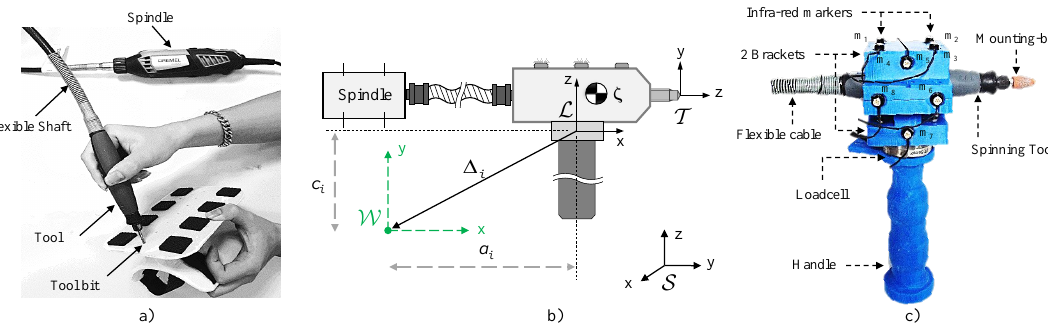
Figure 1. ( a ) Polishing tool’s description. Example of finishing task with a hand-held tool. ( b ) Schematic and naming conventions for the instrumented tool shown in ( c